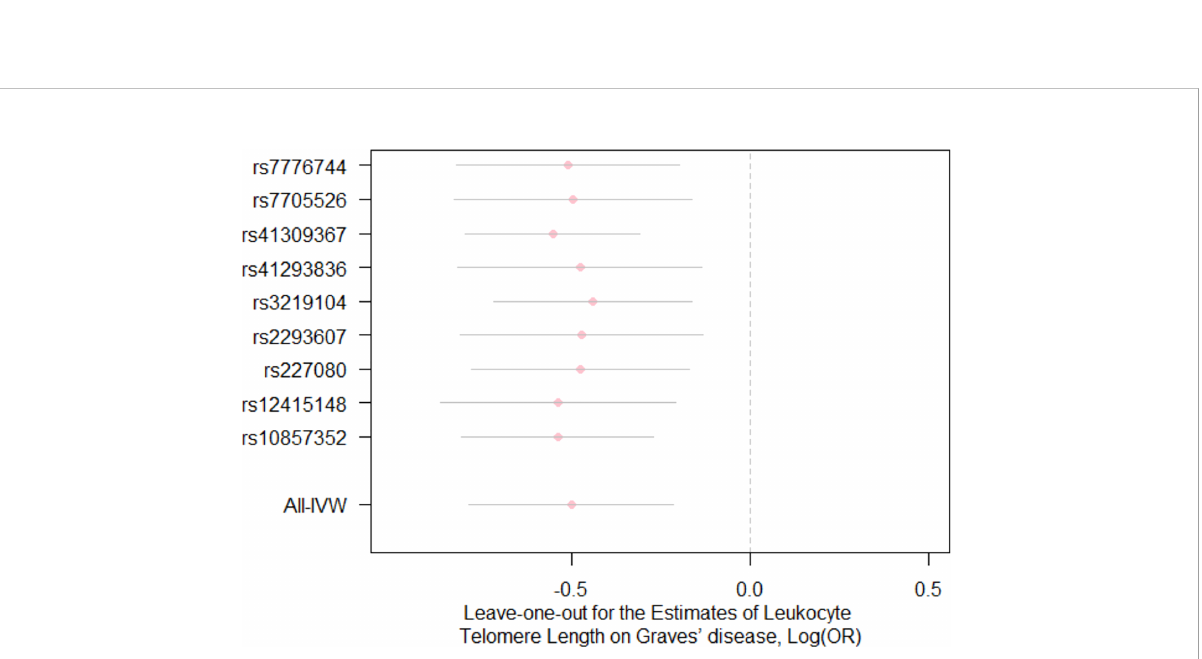
FIGURE 4 Leave-one-out analysis for the estimates for leukocyte telomere length on the risk of Graves ’ disease Each pink dot and grey bar via using the IVW method illustrate the effect estimates and 95%CI for telomere length on the risk of Graves ’ disease when the indicated SNP was removed. The overall effect estimate and 95% CI are represented by the lowest vertical lines using the IVW method. IVW, inverse variance weighted; OR, odds ratio; CI, con fi dence interval.